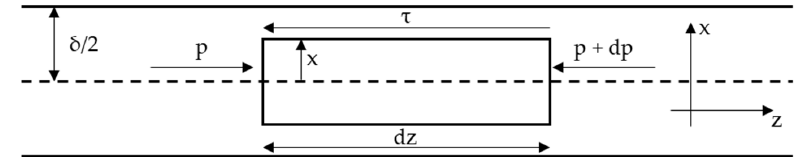
Figure 3. Control volume for the momentum balance in a planar layer.